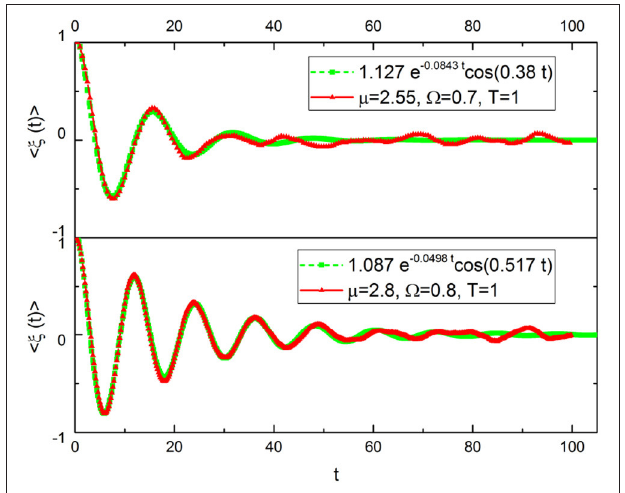
FIGURE 2 | Ensemble average of ξ ( t ), µ = 2.55 (top) and µ = 2.8 (bottom) .